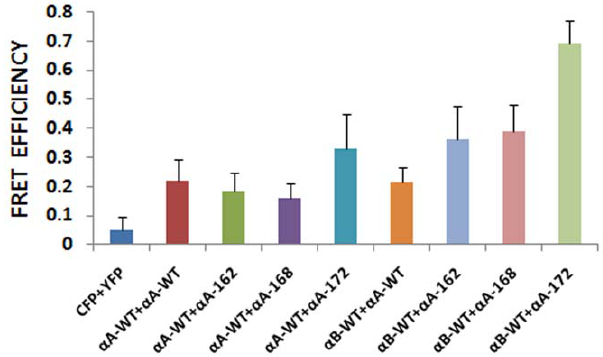
Figure 8. Bar diagram indicating the level of FRET efficiency. FRET efficiency demonstrates the interaction between the a A and a B subunits of a -crystallin. The interaction was strong between the wild types of a A and a B subunits. The interaction between the truncated constructs, a A162 and a A168 with a Awt and a Bwt were lower compared to a A172 expression. The results are expressed as mean 6 Standard Deviation (SD).